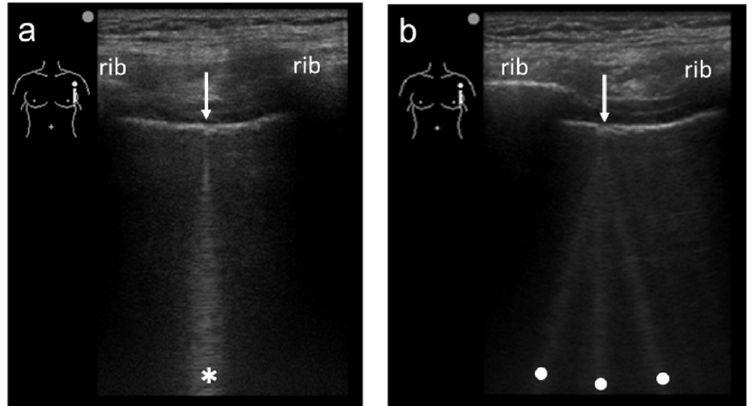
Figure 3. Ultrasound images obtained by MicroMaxx scanner (SonoSite) with a linear transducer without ( a ) and with spatial compound imaging ( b ). A focal point was set as default by the manu- facturer, and it is not shown on the screen. With spatial compound imaging enabled, single B-line (asterisk) changes to multiple lines (dots) radiating from the same point (arrows) on the pleural line.